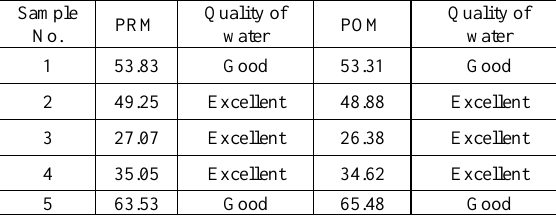
Table 7. Calculation of WQI for individual